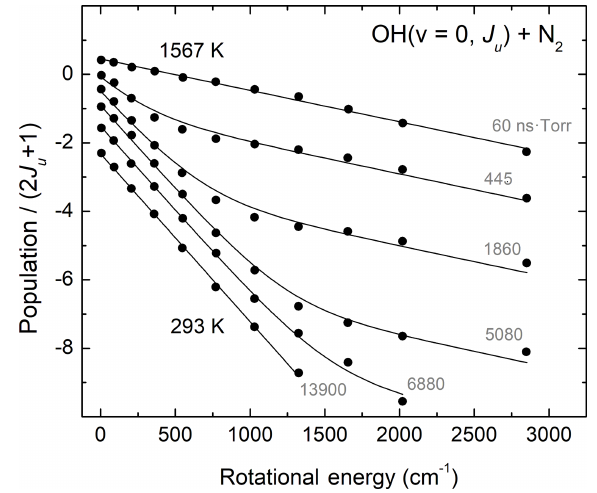
Figure 2. Temporal evolution of a delta function initial rotational population distribution relaxing in a bath gas according to an exponential-gap model with unrestricted (cid:49)J . Adapted from Fig. 4 of Polanyi and Woodall (1972). The alternating black and grey la- bels indicate reduced time units.